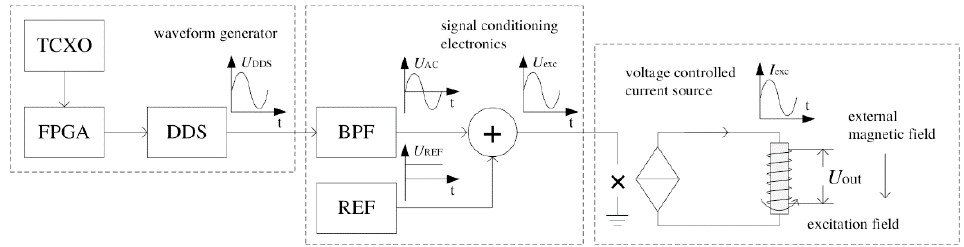
Figure 3. The structure of the excitation module which provides the excitation current in S.X. Song et al.’s